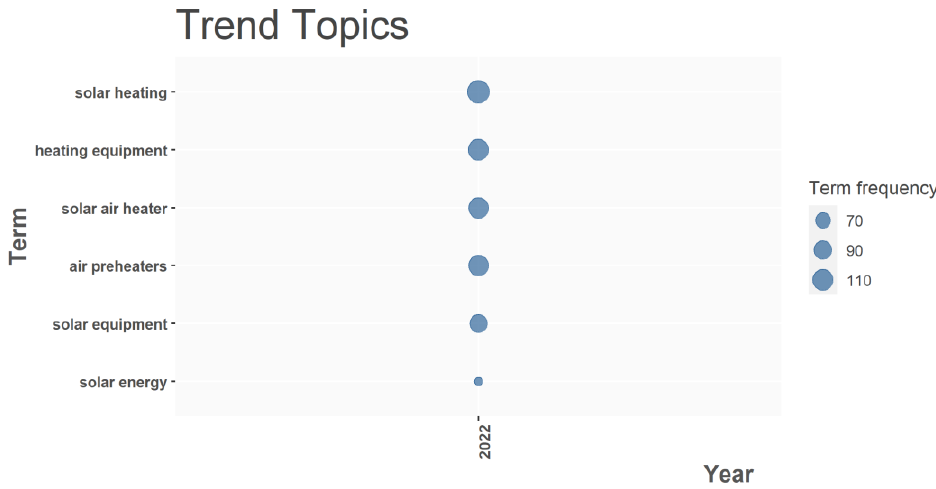
Figure 14. Solar air heaters trends during the period 1 January – 1 August of 2022.